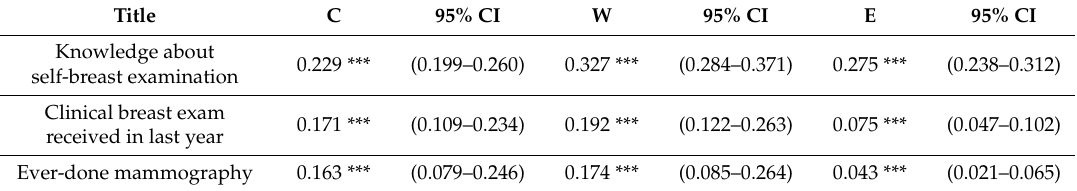
Table 3. Inequality indices in uptake of breast cancer screening by income.